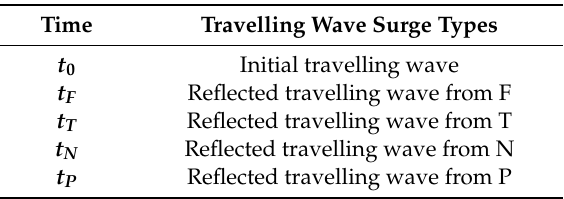
Table 1. Travelling wave types with their reach times.